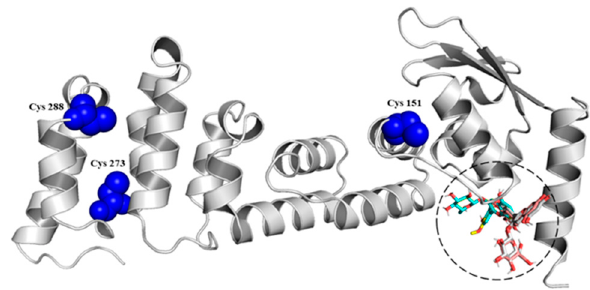
Table 2. Molecular docking results of the anthocyanins evaluated and BTB domain.